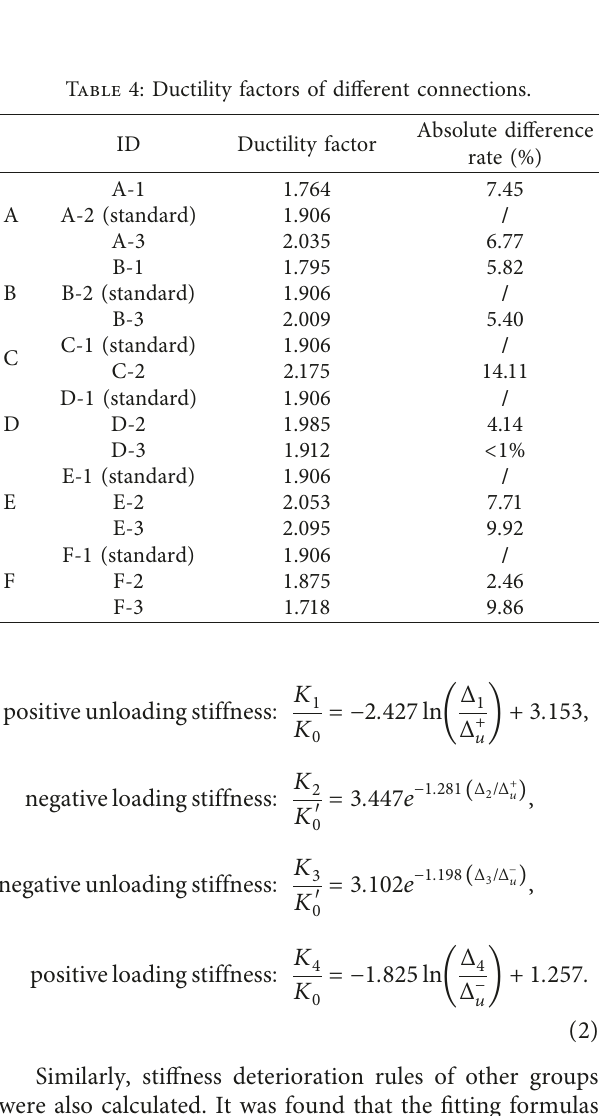
Figure 9: Schematic illustration of the general yielding moment method.